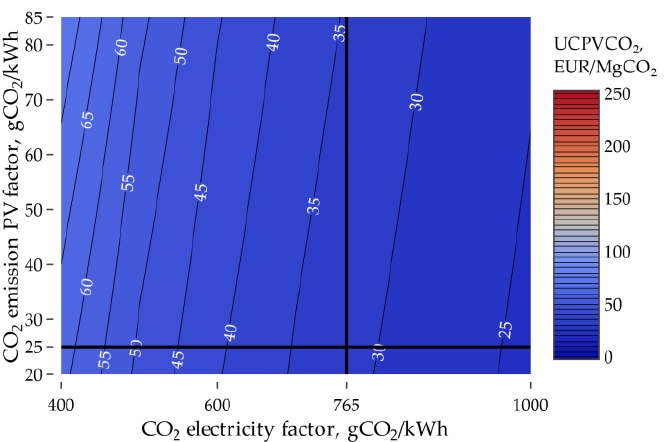
Figure 20. Unit (investment) cost of CO 2 emission reduction as a function of CO 2 emission factor in the national grid and emissions related to the production of Leki panels with subsidy.